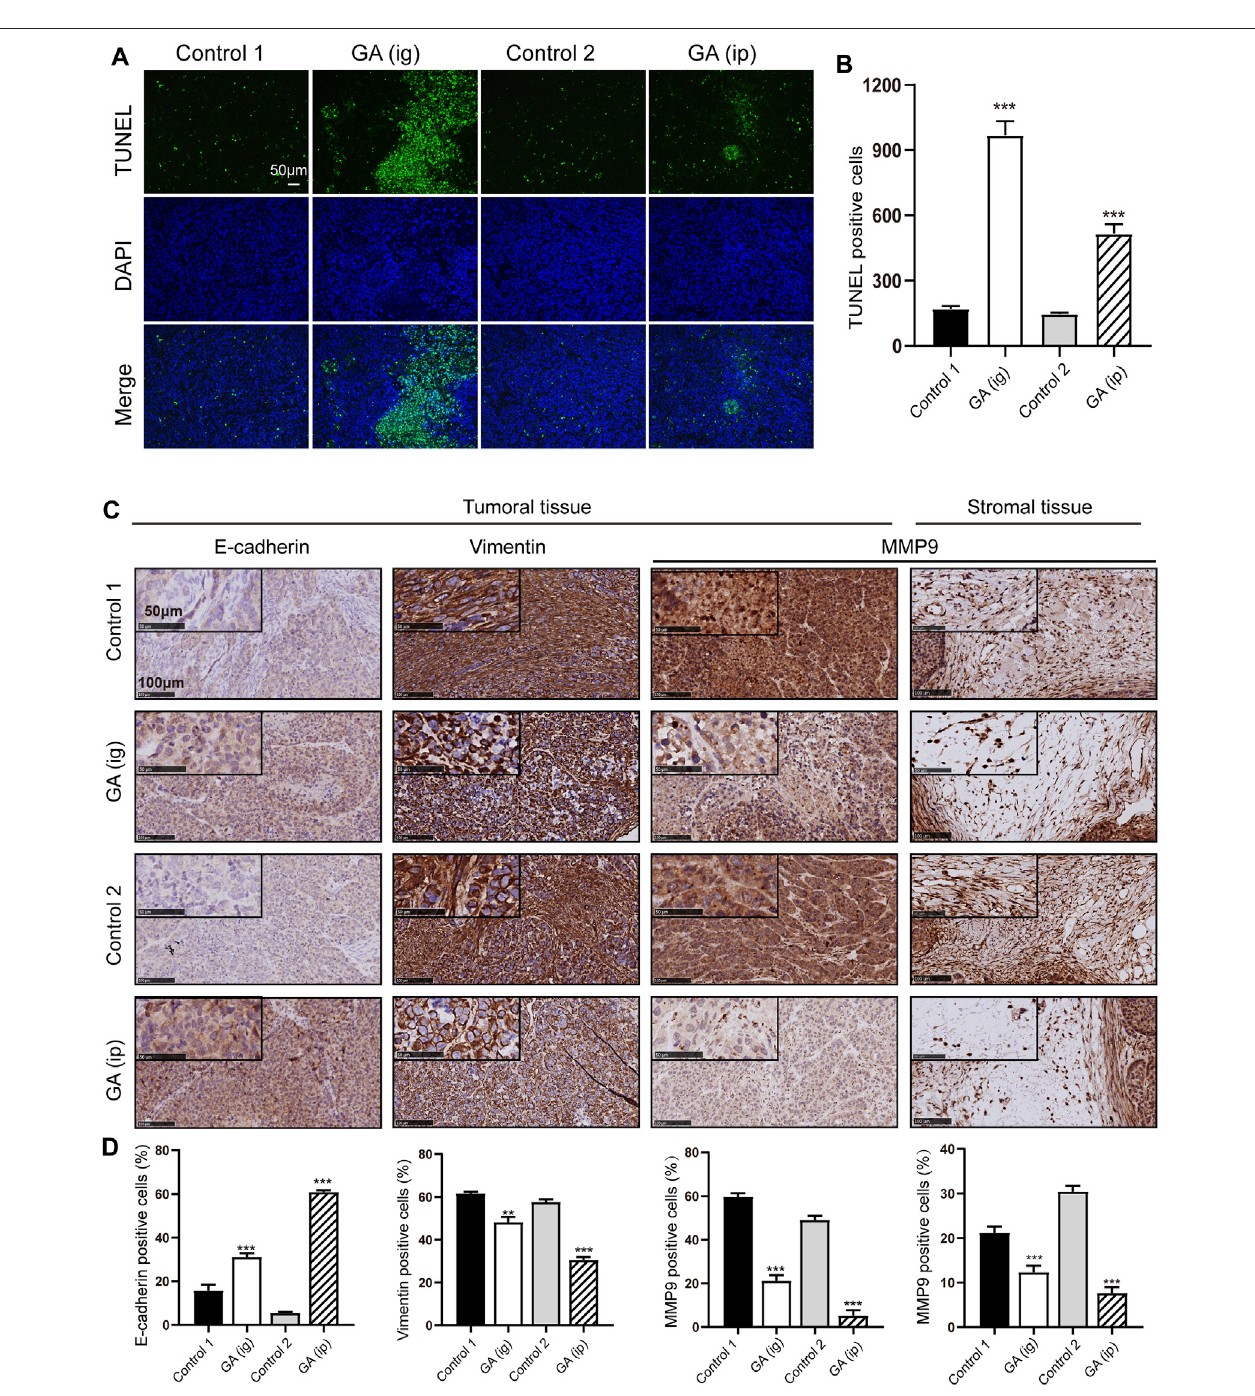
FIGURE 7 | GA induced the apoptosis and inhibited metastasis in vivo. (A) the apoptotic cells in tumor specimens were assessed by using TUNEL assays. (B) Quantitative analyses of TUNEL-positive cells. (C) IHC detection of E-cadherin, Vimentin and MMP9 in tumoral or stromal tissue. (D) Quantitative analyses of IHC examination. *, p < 0.05; **, p < 0.01; ***, p < 0.001; vs Control one or control 2.